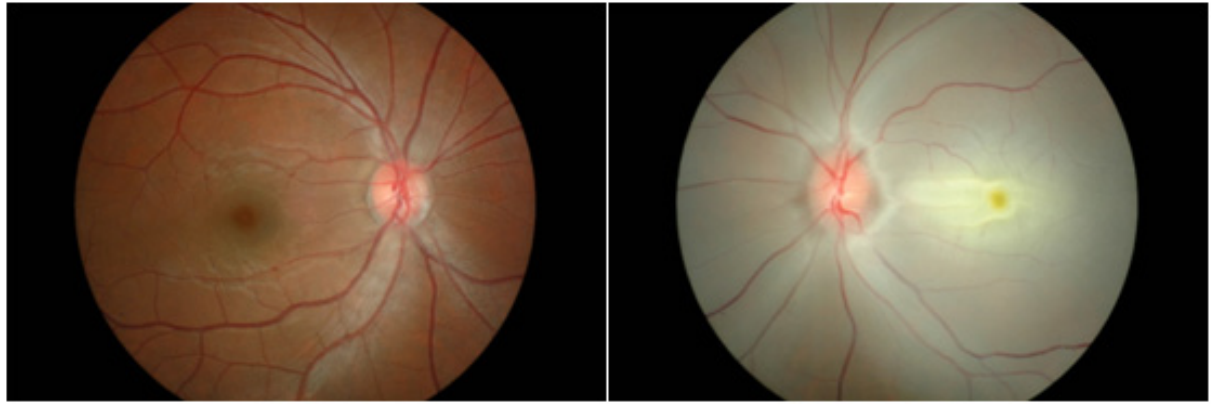
Figure 1. Fundus photograph showing marked whitish retina and a cherry-red spot at the macula of the left eye.